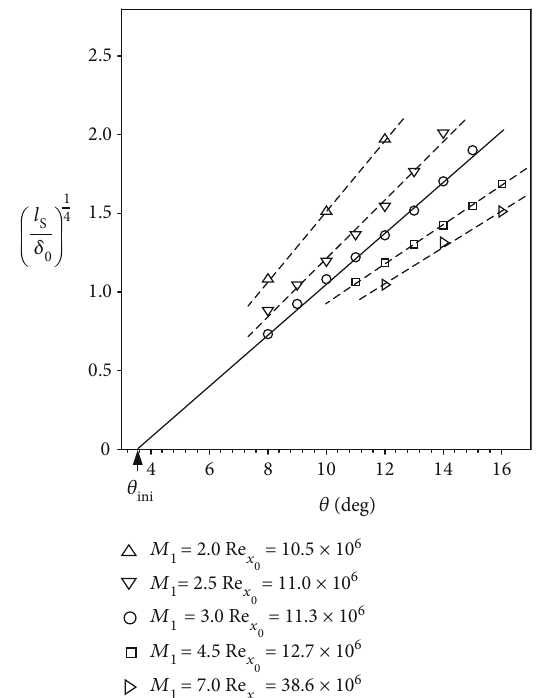
Figure 7: Linear fi ts of fl ow de fl ection angle with the separation